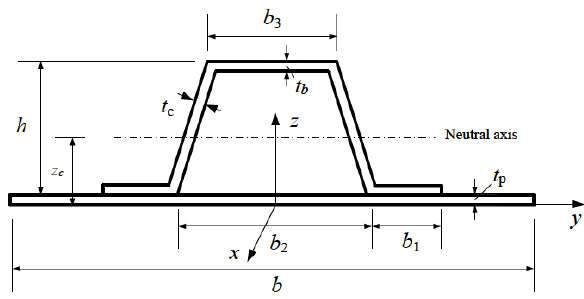
Figure 2: Section of a plate-stiffener combination